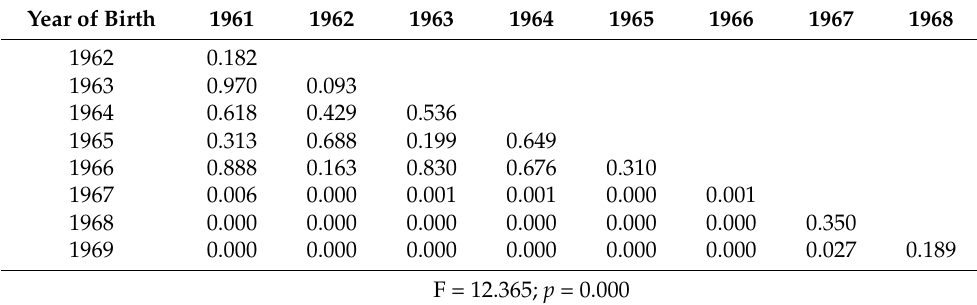
Table 3. Differences in body weight values presented by year of birth.